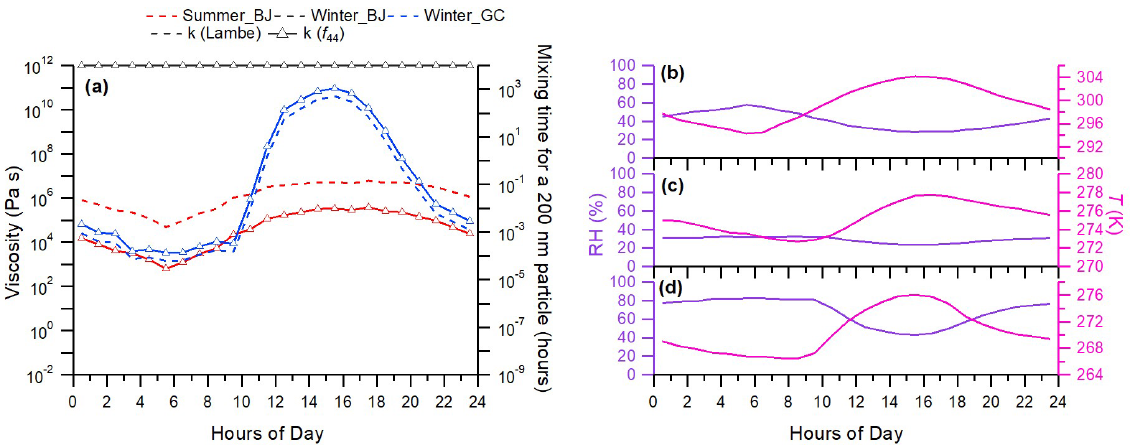
Figure 7. Diurnal variations in (a) viscosity of total OA and ambient RH and T in Beijing in (b) summer and (c) winter. The diurnal cycles of ambient RH and T in Gucheng during wintertime are shown in (d) . Characteristic mixing timescales of organic molecules with a radius of 10 − 10 m within 200nm particles are also shown on the right